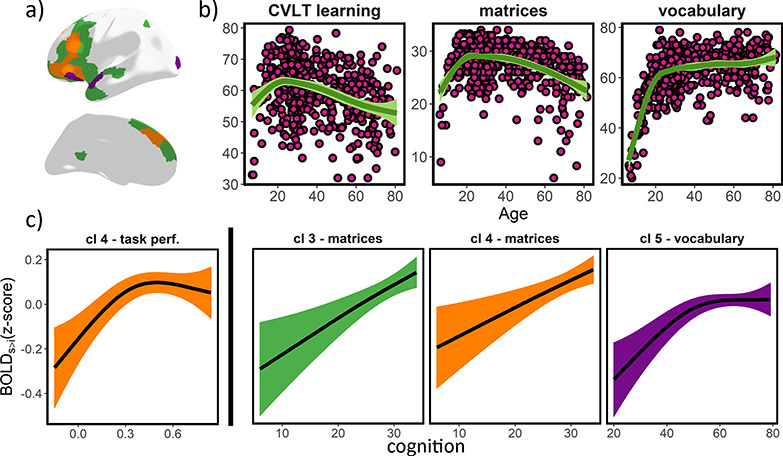
Episodic encoding activity—cognitive function relationships. (a) Topography for cluster 3, 4, 5 (green, orange, purple; left hemisphere only). (b) Lifespan trajectories of CVLT learning, matrices, and vocabulary scores. (c) Significant (FDR-corrected) relationships between cluster activity and cognitive function, controlling for age and sex. x-axis represents test scores and y-axis represents (source-v-item) encoding activity. Ribbons represent 95% confidence intervals. Note that activity (y-axis) values are derived from a PCA (within cluster), and thus demeaned. For clusters 3–5, higher values represent stronger positive memory effects (see Fig. 2). BOLDS > i = Subsequent source versus item memory fMRI contrast.